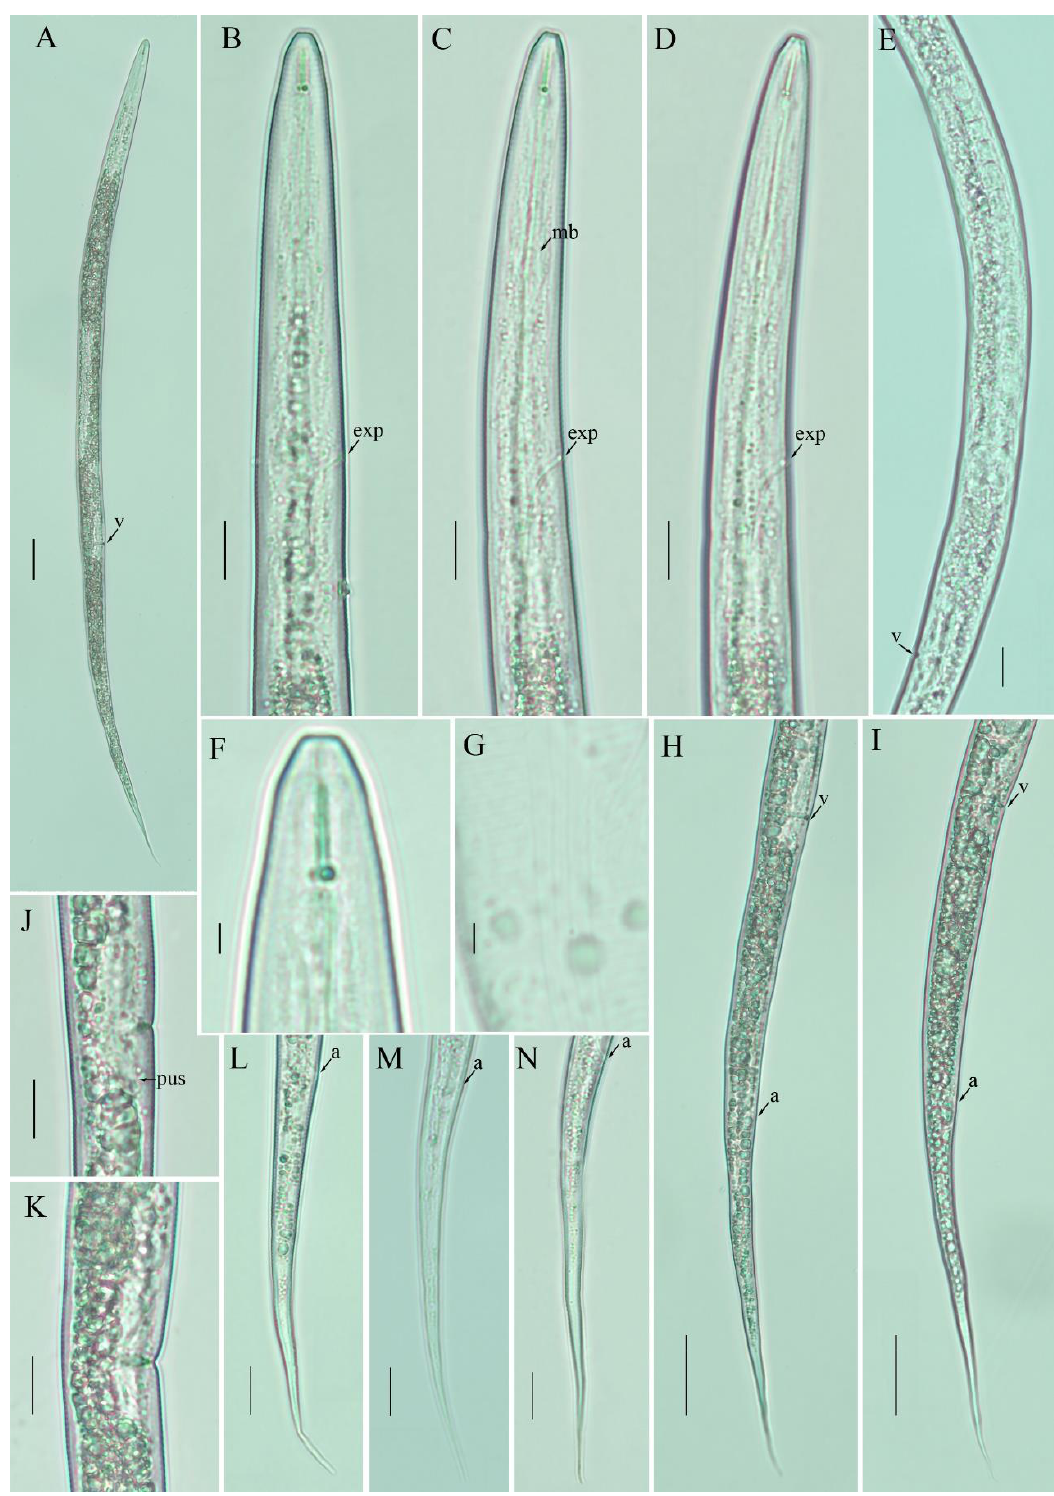
Figure 4. Photomicrographs of female Filenchus thornei (Andrássy) Andrássy [1,23]. ( A ) Entire body; ( B – D ) pharyngeal regions; ( E ) gonad; ( F ) lip region; ( G ) lateral lines; ( H , I ) posterior body to tail terminus; ( J,K ) vulval regions; ( L – N ) tail region. Scale bars: ( A ) 50 µm; ( B – E , H – N ) 20 µm; ( F , G ) 5 µm. Arrowheads: (a) anus; (exp) excretory pore; (mb) median bulb; (PUS) post-uterine sac; (v) vulva.